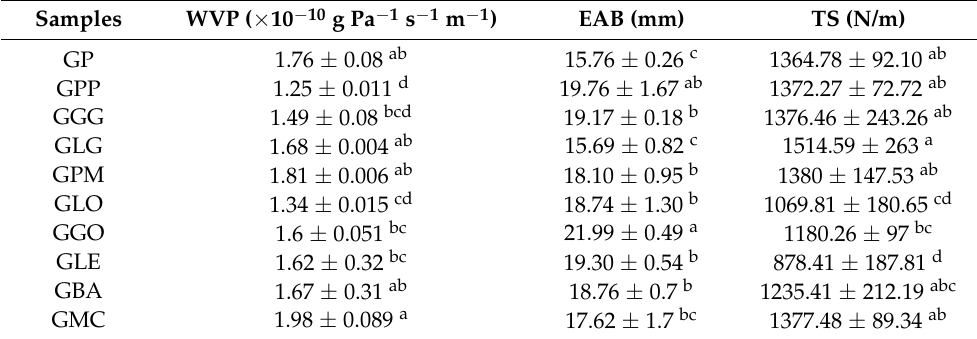
Table 3. Effects of essential oils and plant extracts on water vapour permeability and mechanical properties of the studied edible